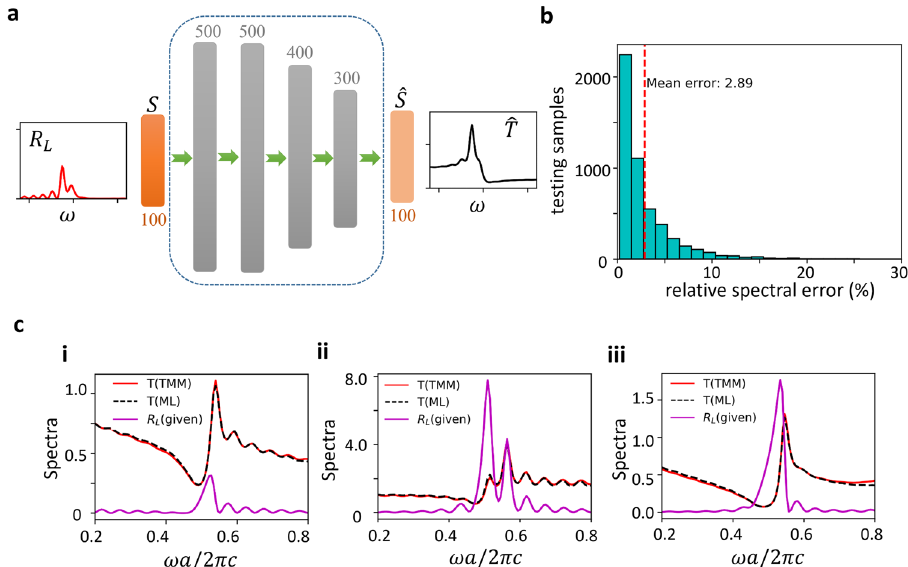
Fig. 2 Designed neural network for left re fl ection to transmission mapping. a Architecture of the optimized network, showing the left re fl ection R L as function of frequency ω as input and the predicted transmission ^ T as function of ω as output. b Histogram of the spectral prediction error. c Three representative examples for generation of transmission response T (using Transfer Matrix Method: TMM and Machine Learning: ML) from three different given re fl ection spectra R L versus normalized frequency ω a /2 π c , with a the dimension of the scatterer and c the speed of light in free space. The solid red and dotted black line represent the transmission calculated from TMM and ML method, respectively. More examples are shown in Supplementary Fig.